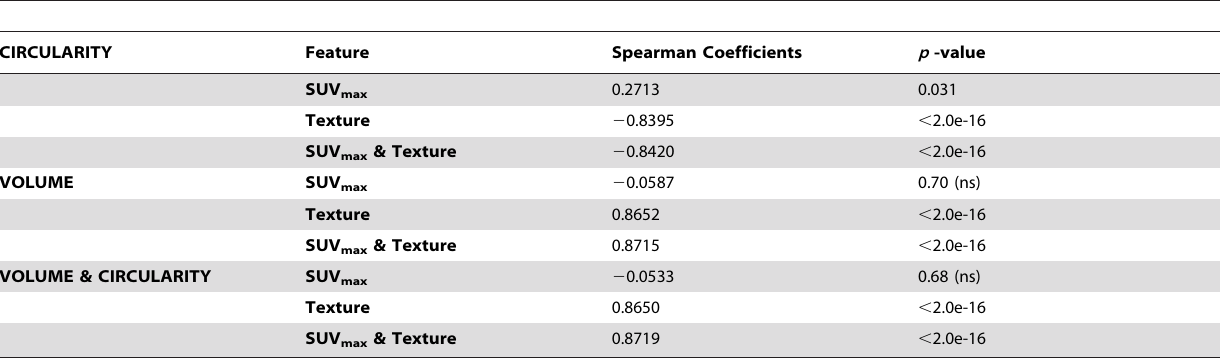
Table 4. Longitudinal assessment of morphological changes of uptake regions through SUV max , texture, and combined SUV max and texture features are given with corresponding spearman coefficients and